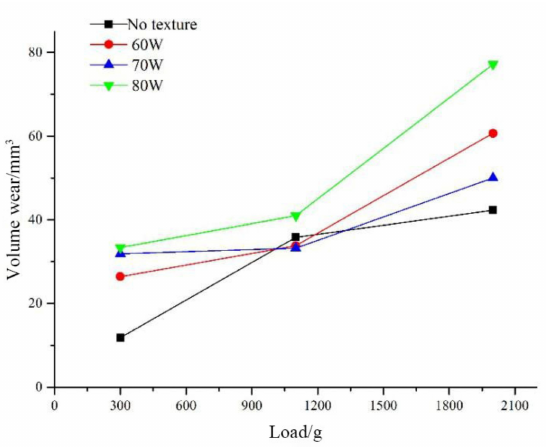
Figure 18. Curve of average volumetric wear loss with various